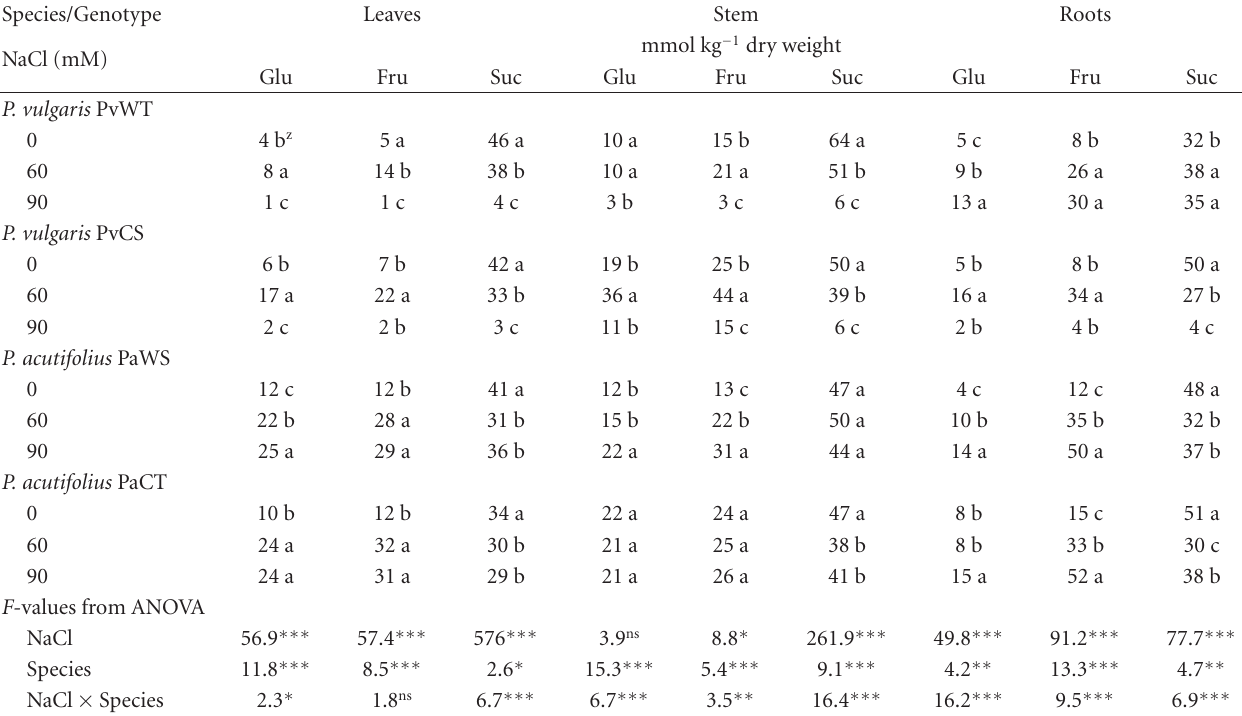
Table 2: E ff ects of external NaCl concentrations on glucose (Glu), fructose (Fru), and sucrose (Suc) of leaves, stem, and roots of Phaseolus